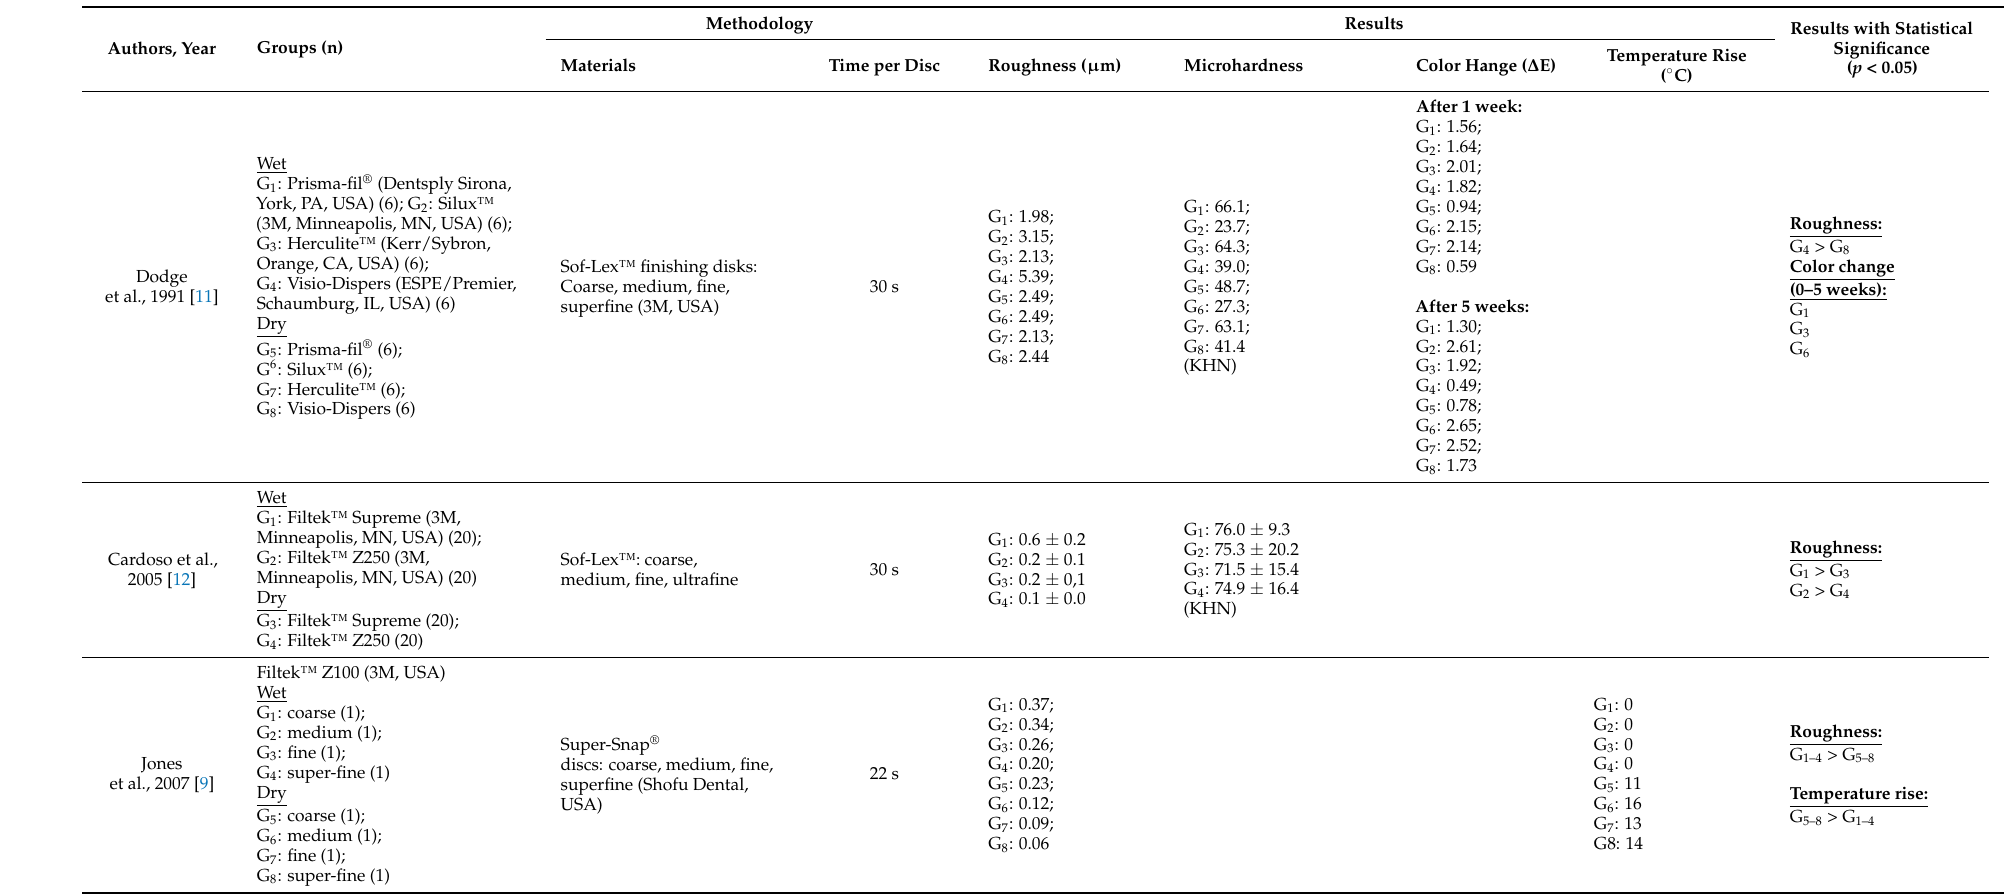
Table 3. Summary of the included